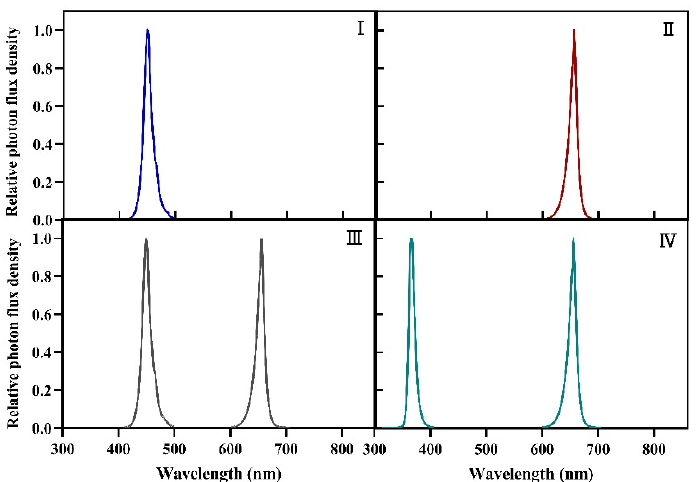
Figure 1. Relative photon flux density of the four light regimes employed for cultivation. These included monochromatic blue (B; I ), monochromatic red (R; II ), a mixture of R and B ( III ), as well as a mixture of R and UVA ( IV ).